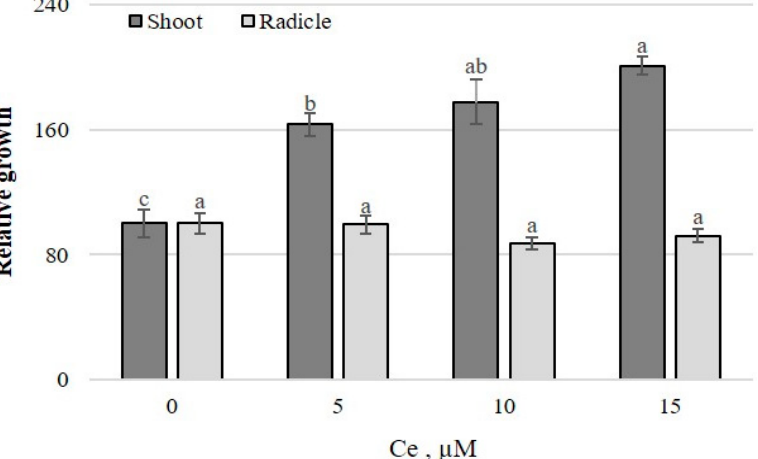
Figure 6. Relative growth of shoots and radicles of tomato ( Solanum lycopersicum L.) cv. Vengador seedlings after seven days in germination chambers, treated with solutions with different Ce con- centrations. Means ± SDs with different letters in each parameter indicate significant statistical dif- ferences (LSD, 0.05).